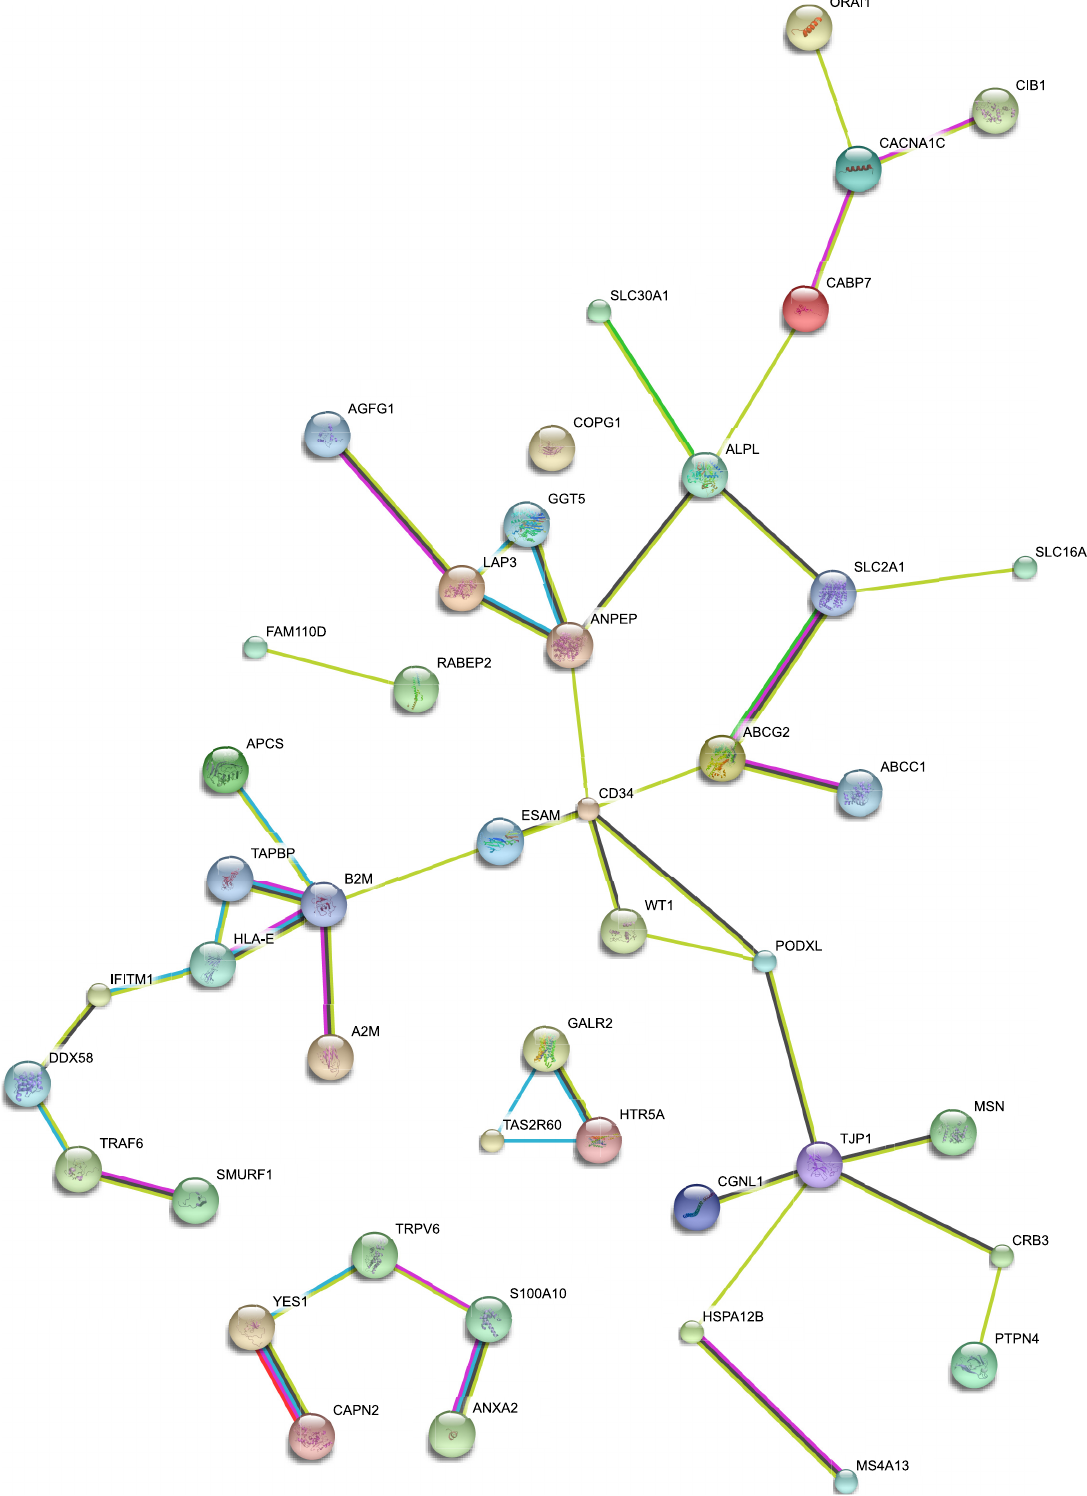
Fig 4. Protein interaction networks among vascularproteins identified from the Human Protein Atlas. We appliedthe STRING tool (string-db.org; Version 10.0) to humanbrain EC proteins to identify possiblenovel networksamong molecules. The graphical representation of proteinsidentifiedas havingat least one connectedpartner in the EC protein set are presented